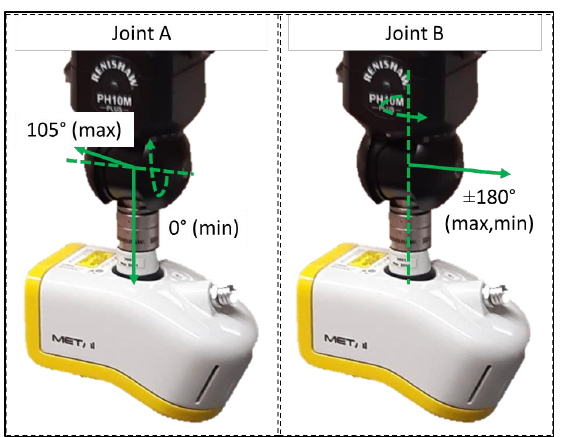
Figure 2. The LLS and aph with the limits of both